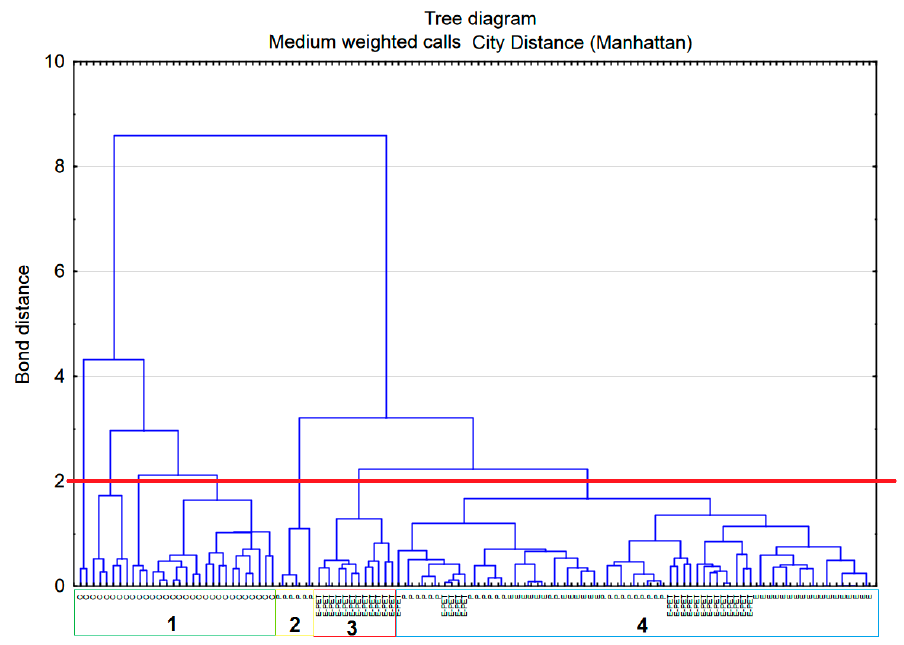
Figure 11. Dendrogram obtained for the four types of mortars.